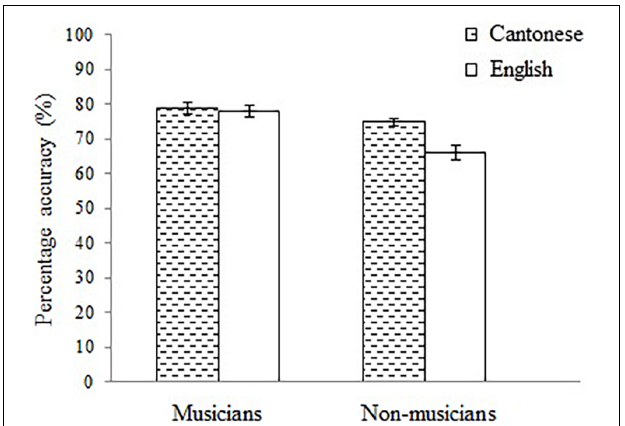
FIGURE 1 | Mean pitch score of the Cantonese musicians, Cantonese non-musicians, English musicians, and English non-musicians. The error bars represent the standard error of the mean.